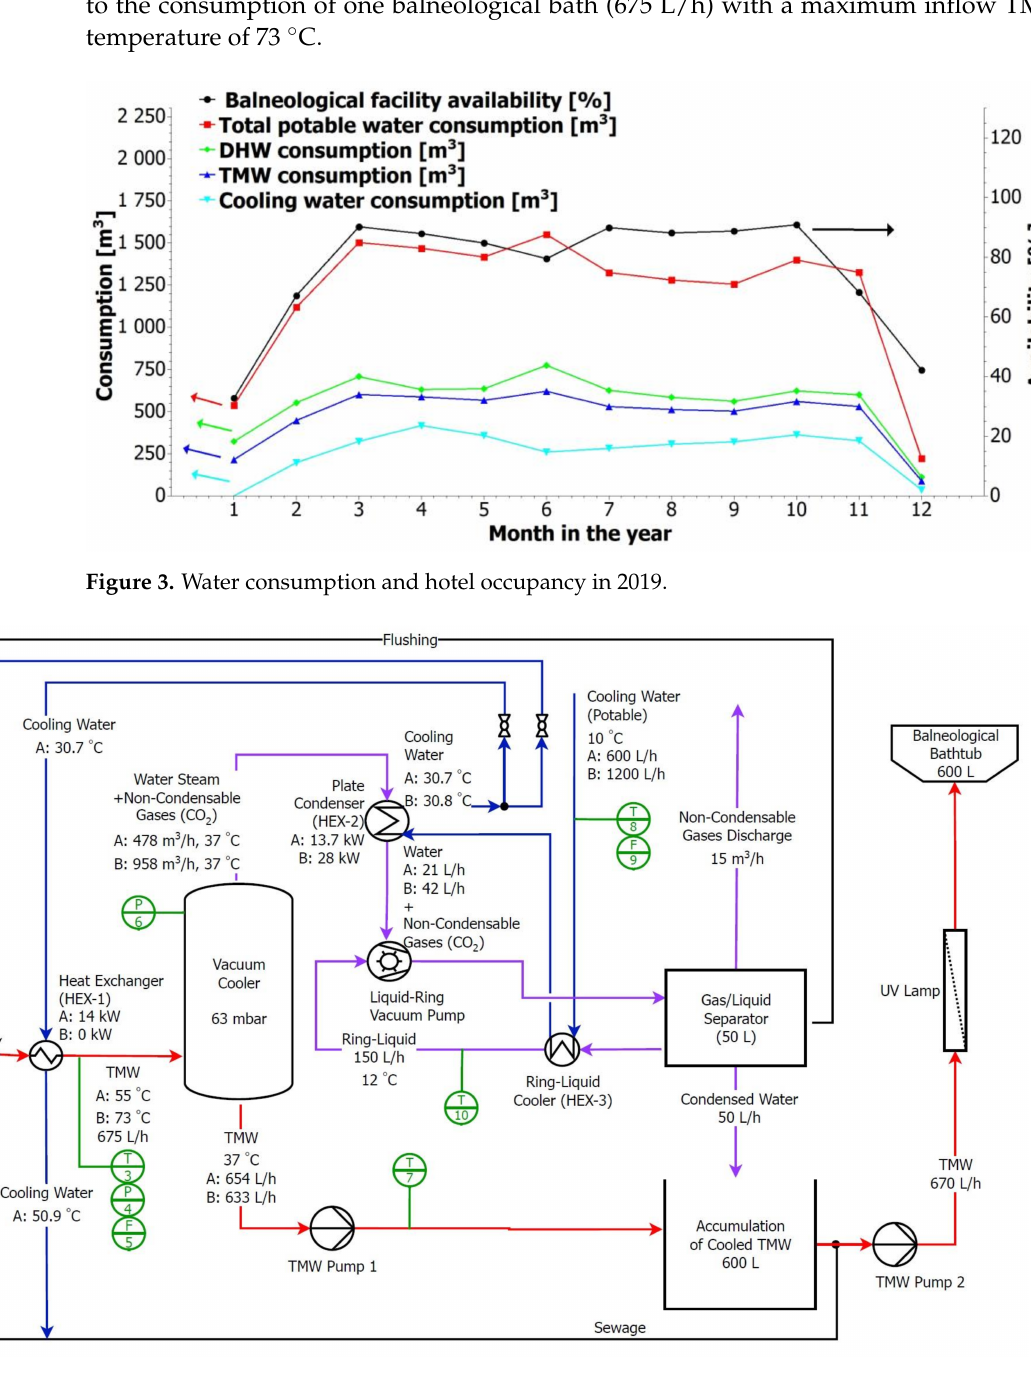
Figure 4. Process flow diagram of the pilot unit for TMW